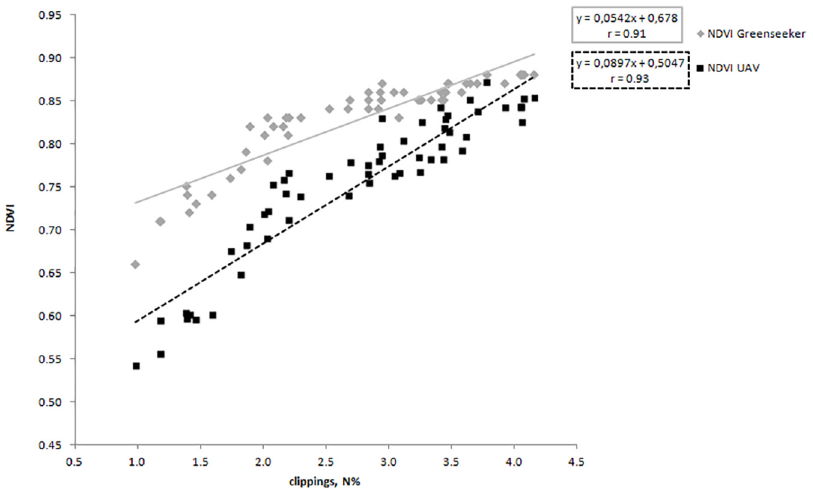
Fig 3. Relationships between the clippings nitrogen content of Cynodon dactylon x transvaalensis and NDVI data obtained with a ground-based spectral reflectance instrument (Trimble ’ s GreenSeeker sensor) and an unmanned aerial vehicle (UAV). Values represented the 4 replications.